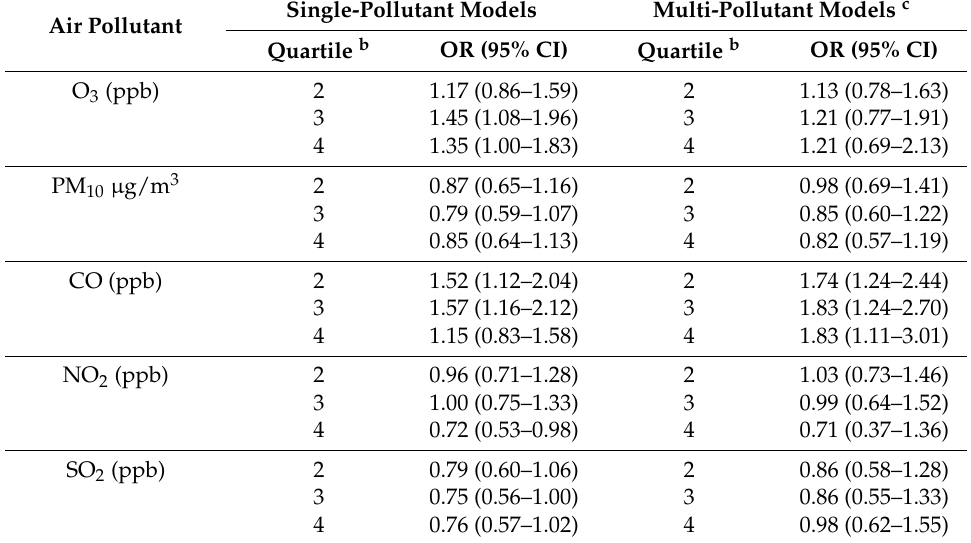
Table 4. Conditional logistic regression results from the single- and multi-pollutant models for adjusted associations between one-year air pollutant concentration and rheumatoid arthritis in adults a ( n =